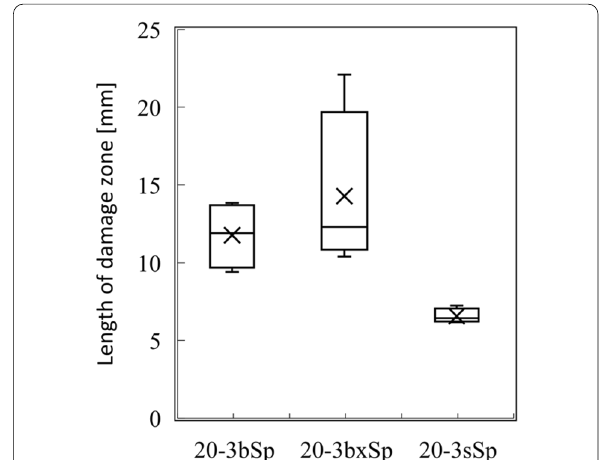
Fig. 13 Length of damage zone of specimens with wood–wood joints and wood–steel joints